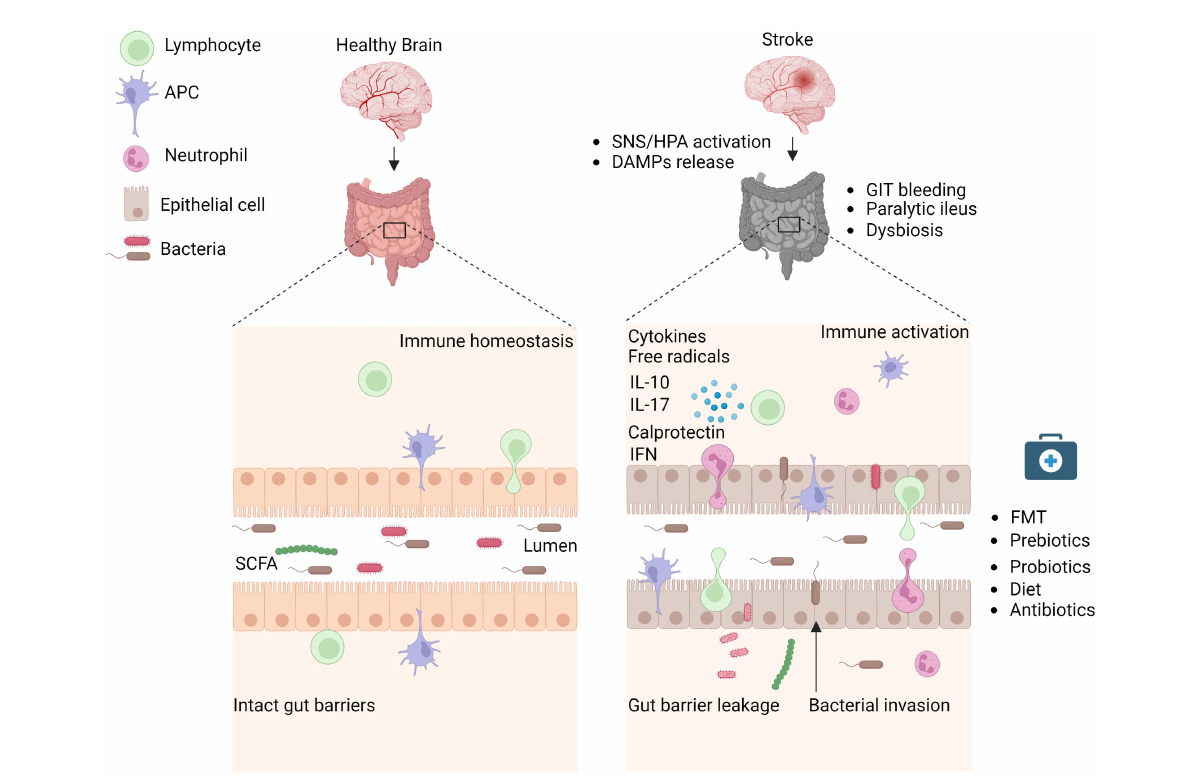
FIGURE 1 Stroke induces intestinal paralysis, barrier leakage, and in fl ammation. Left panel: In healthy conditions, there is immune homeostasis at intact intestinal barriers with balanced microbiota. Right panel: After stroke, the activation of SNS/HPA axis and release of DAMPs trigger microbiota dysbiosis, and paralytic ileus and promote immune cell-driven in fl ammation. Activated neutrophils, macrophages, and dendritic cells release toxic cytokines, free radicals, and proteases and cause epithelial damage. Invasion of intestinal bacteria to systemic tissues enhances immune cell activation and neuroin fl ammation. Rebalance of dysbiotic microbiota with pre and probiotics, food supplements, or its depletion with antibiotics is associated with reduced brain in fl ammation and improved stroke outcome in experimental studies and their application to stroke patients requires validation. APC, Antigen-presenting cell, DAMPs, Damage-associated molecular patterns, FMT Fecal microbiota transplantation, HPA, Hypothalamus Pituitary Adrenal; IFN, Interferon; IL, Interleukin; SCFA, Short-chain fatty acid; SNS, Sympathetic Nervous System. Created with